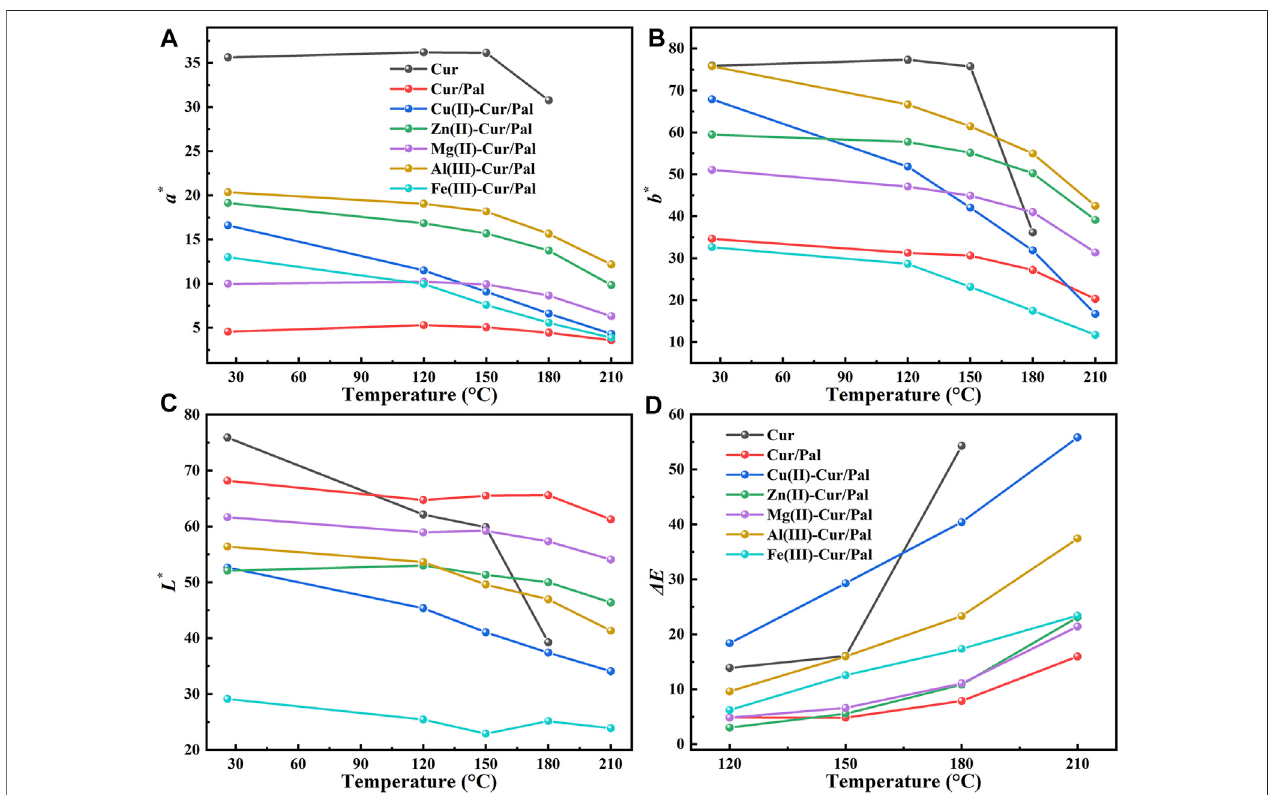
FIGURE 7 | CIE (A – C) and Δ E* (D) values of Cur, Cur/Pal and metal ions-Cur/Pal hybrid materials after being heated at different temperatures.